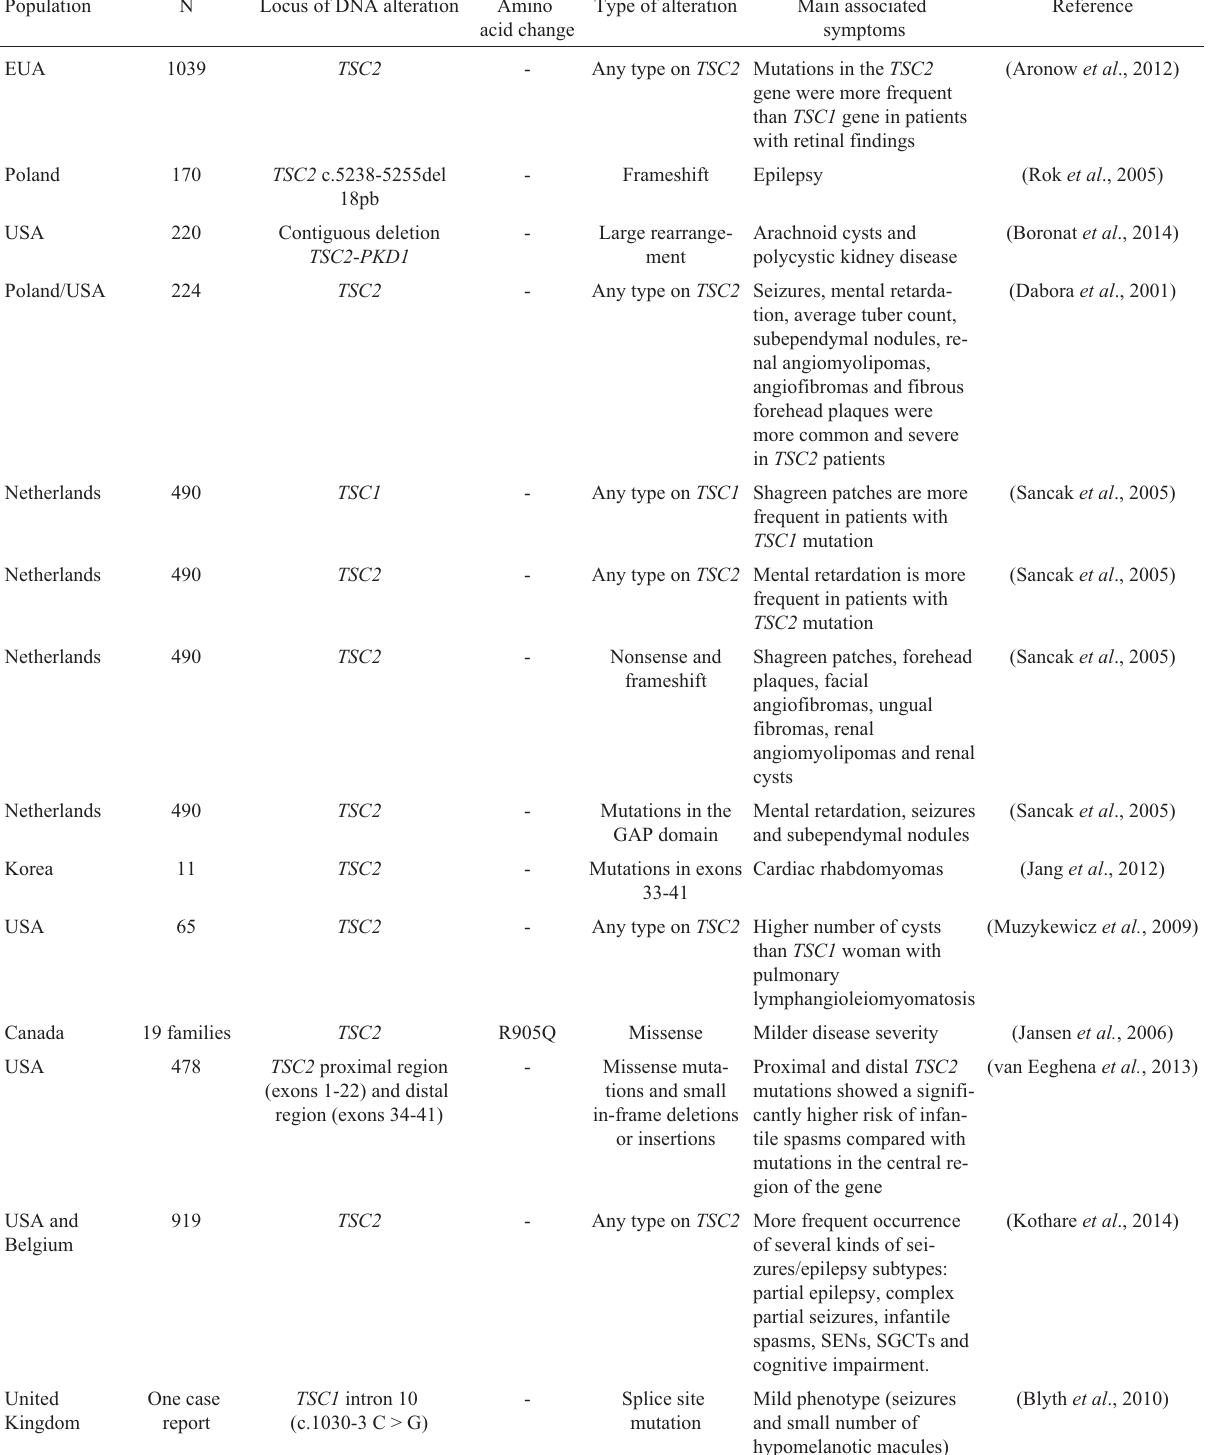
Table 3 - Genotype-phenotype correlations established for TSC